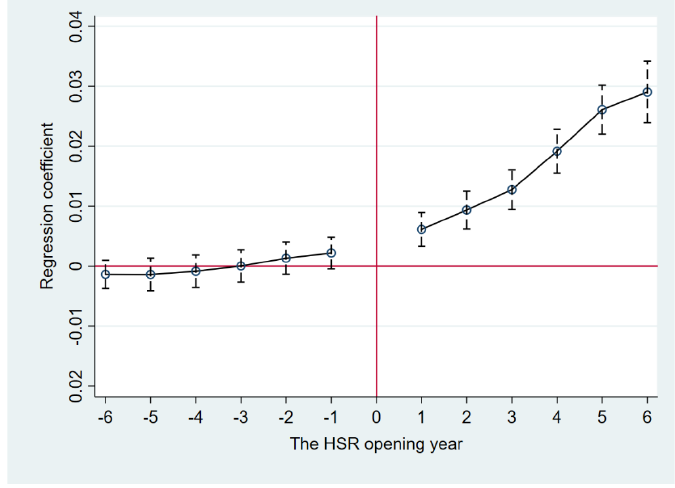
Figure 1. Parallel trend test chart.